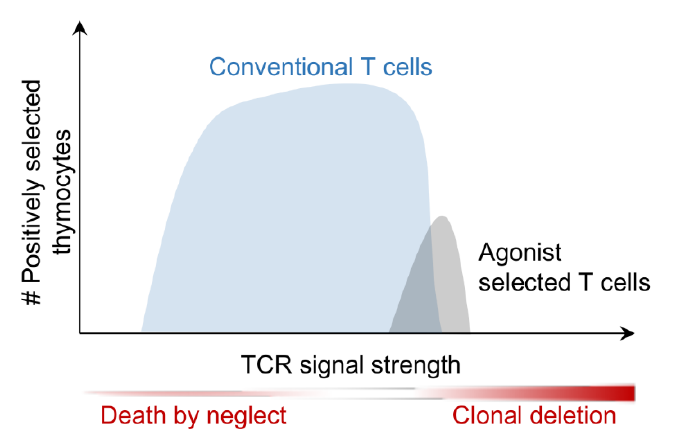
Figure 1. Conventional and agonist selected T cells possess different affinity windows for positive selection. Conventional T cells require low to moderate TCR affinities to peptide: MHC to receive survival signals, whereas agonist selected T cells depend on relatively high affinities towards peptide: MHC to be positively selected.